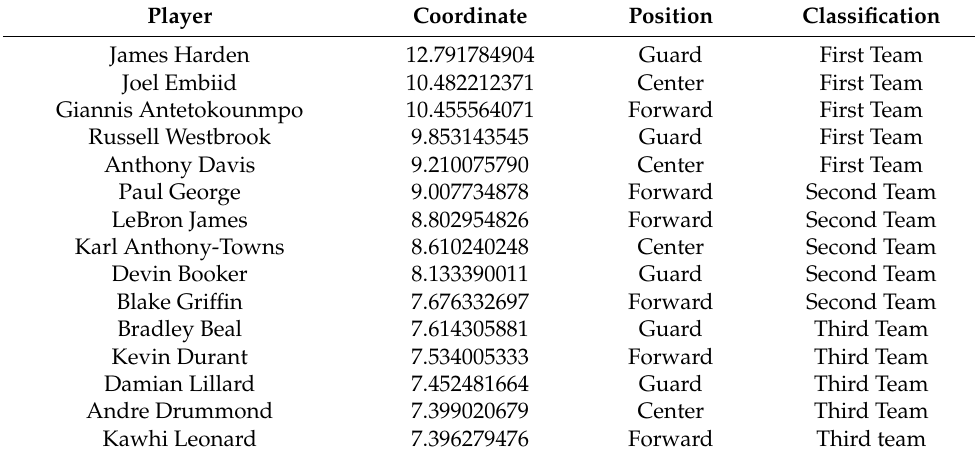
Table 5. Players selected to the All-NBA Teams through PC1 in the 2018-10 NBA Season. Player Coordinate Position Classification James Harden 12.791784904 Guard First Team Joel Embiid